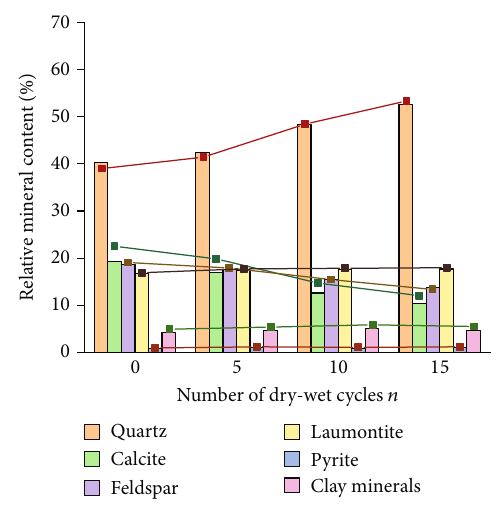
Figure 12: Changes in mineral composition of samples under dry – wet